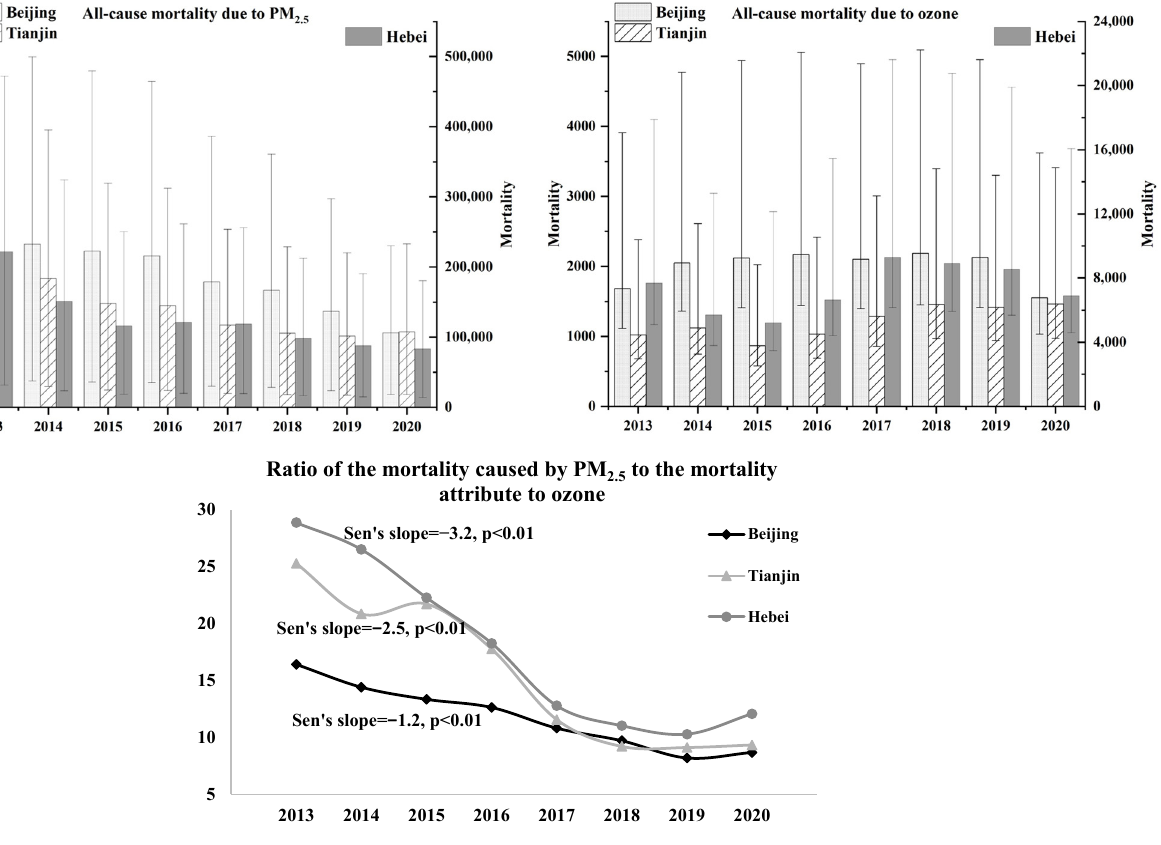
Figure 6. All-cause mortality owing to exposure to PM 2.5 ( upper left ), ozone ( upper right ), and ratio of the mortality attributable to PM 2.5 to the mortality attributable to ozone ( lower ) in the Beijing–Tianjin–Hebei region. Note: Error bar in the upper images means the 95% confidence interval.